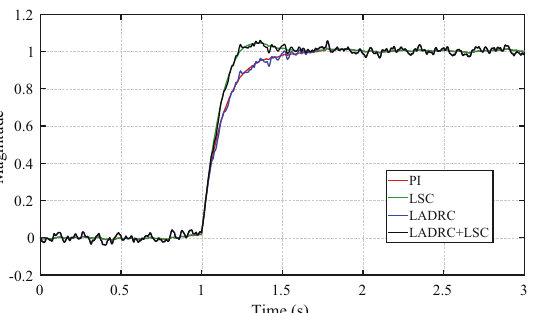
Figure 12. Unit step response with added band-limited white sensor noise of 1 × 10 − 5